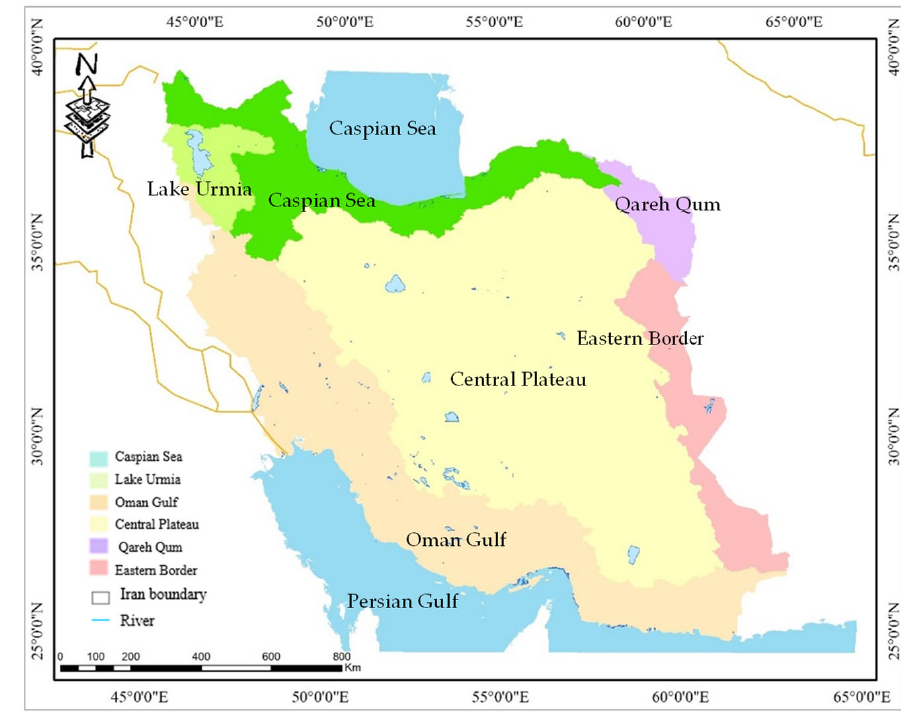
Figure 1. Location main basins in the studied